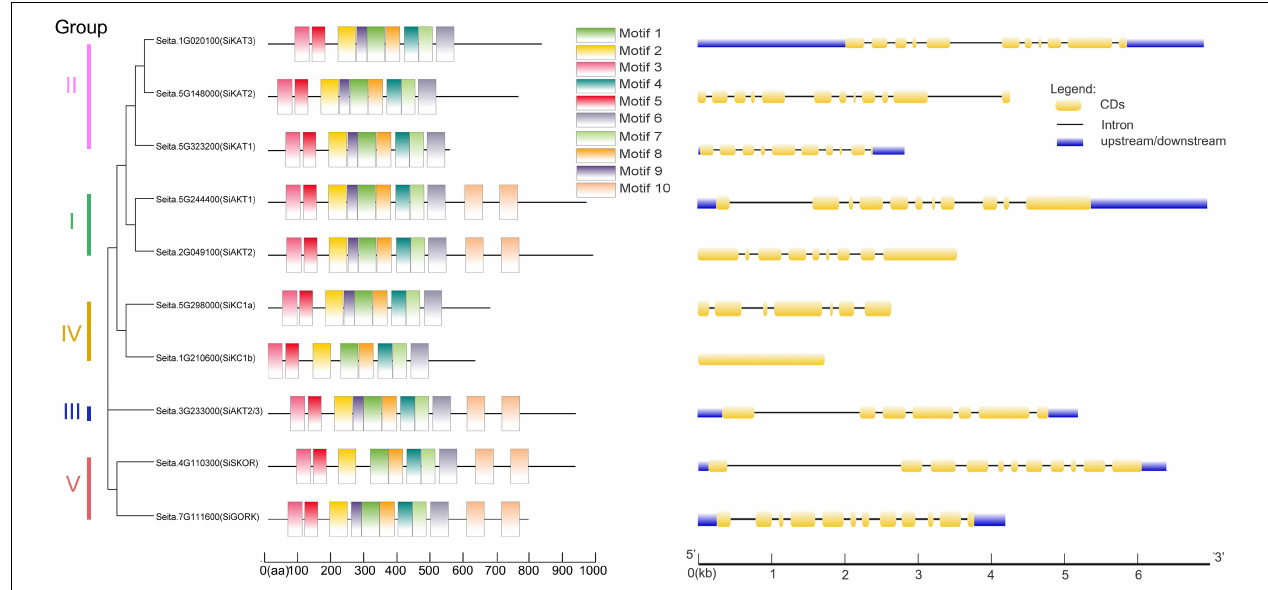
FIGURE 2 | Protein motifs and gene structures of Shaker K + channels from foxtail millet. (Left) In the Shaker K + channel proteins, 10 motifs were identified by the MEME tool, represented by different colors (1–10) and depicted by TBtools. (Right) The exon-intron structure of these Shaker K + channel genes was predicted by GSDS 2.0. The yellow boxes represent the coding sequence (CDs), the black lines represent introns, and the blue boxes represent up/downstream untranslated regions